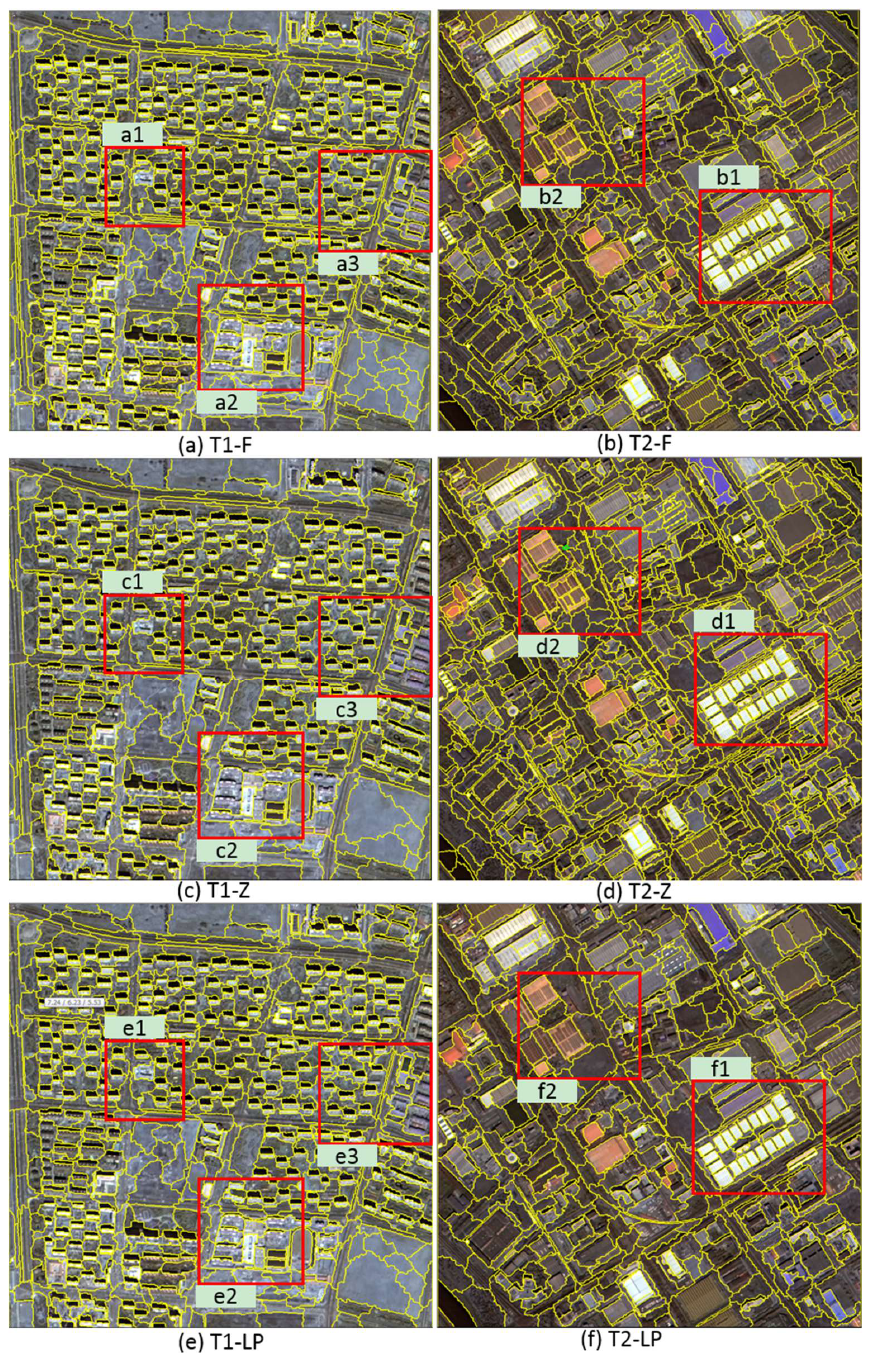
Figure 7. The segmentation results of the test images T1 and T2 produced by the MRS method with the optimal scales obtained by the three combination methods.